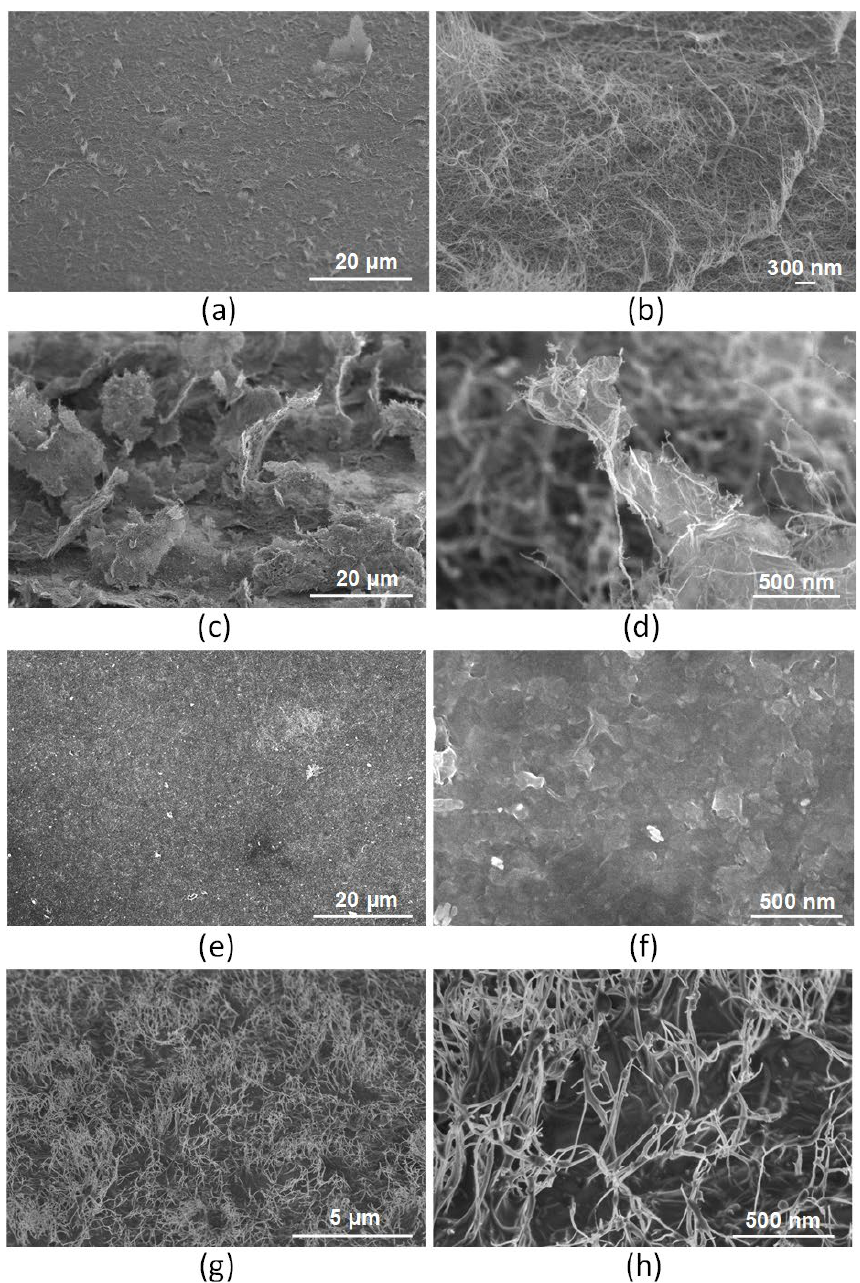
Figure 8. SEM images of layer structures based on: ( a , b ) SWCNT, ( c , d ) rGO/SWCNT hybrids after laser exposure with an energy density of 0.5 J/cm 2 ; ( e , f ) rGO layer after laser exposure with an energy density of 0.8 J/cm 2 , and ( g , h ) rGO(bl)-SWCNT hybrid nanostructure with a buffer layer of rGO after laser exposure with an energy density of 0.8 J/cm 2 and a main layer of SWCNT after laser exposure with an energy density of 0.5 J/cm 2 .